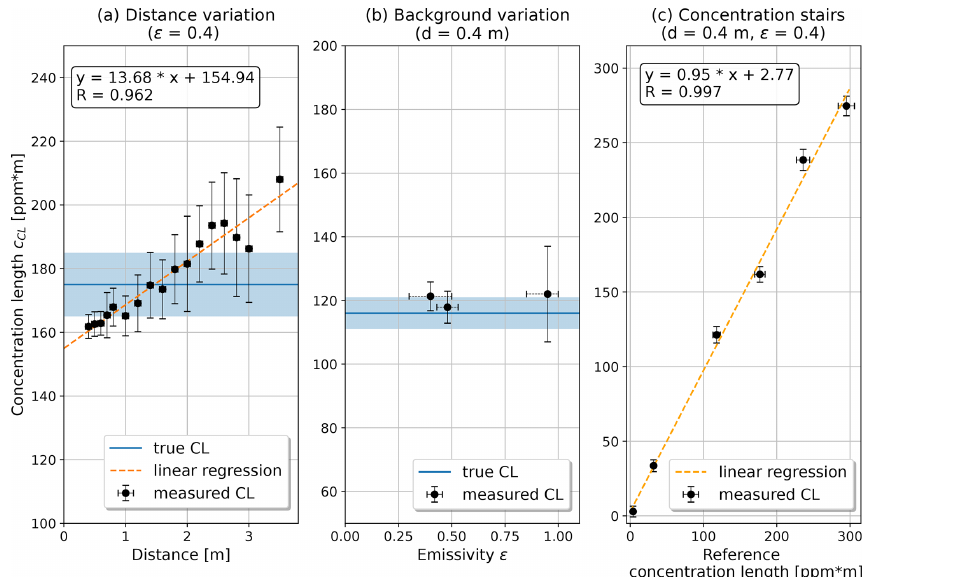
Figure 5. The measured concentration lengths ( c CL ) are validated against three influences: (a) the effect of varying the distance between camera and the metal reflective element ( ε = 0 . 4), where the slope of the linear fit may show twice the methane (because the light is absorbed on the way to the target and back) in the gas laboratory ( ∼ 6 . 8ppm); (b) the effect of reflective elements with different emissivities; and (c) the effect of varying the reference methane concentration at a distance of 40cm from the metal reflective element, where the linearity is off by 5%. In panels (a) and (b) , the blue line shows the methane concentration length in the reference cell, and the light blue area denotes its uncertainty.